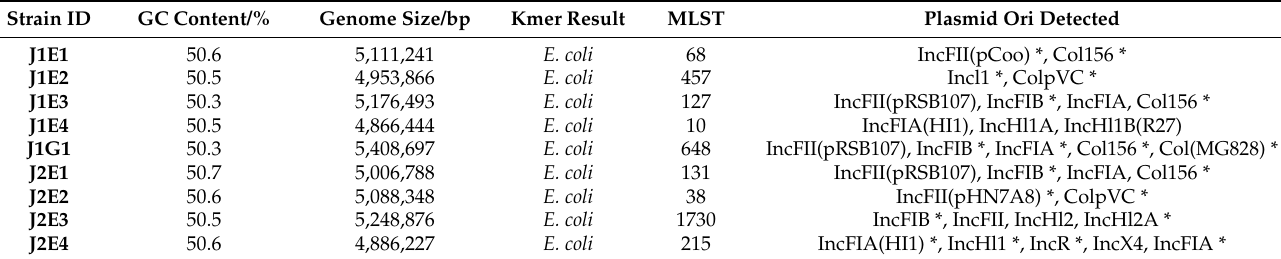
Table 1. Basic information of the